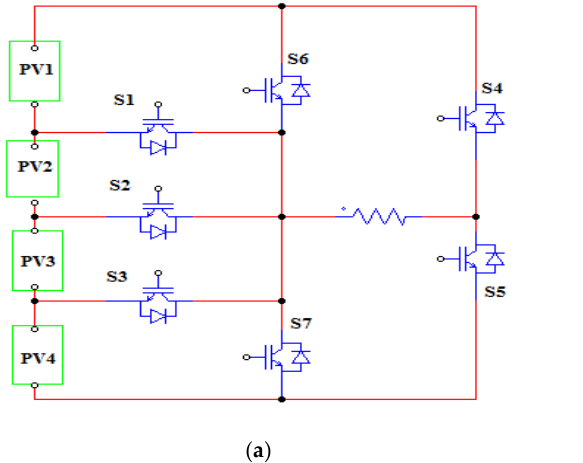
Figure 16. Nine-level, seven-switch proposed topology ( a ) based on four series of DC sources and ( b ) on a single DC source and four capacitors.